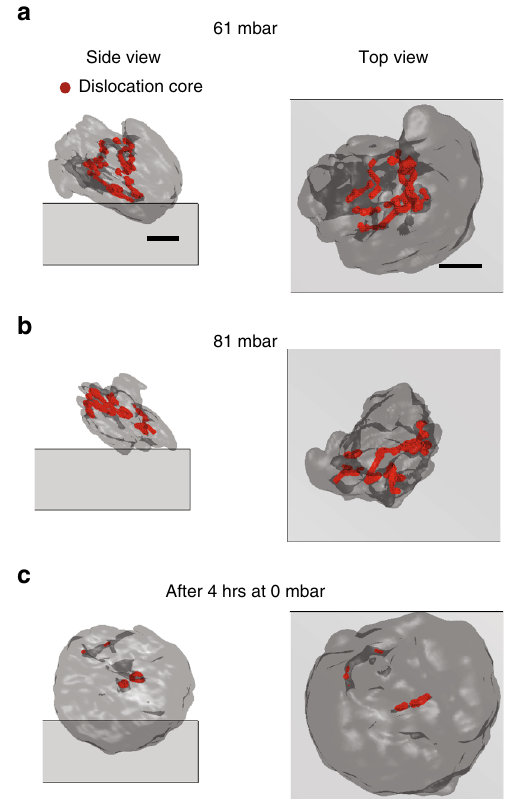
Fig. 2 The 3D dislocation network evolution due to changes in hydrogen partial pressure. The particle shape is shown as a black semi-transparent isosurface, the substrate is shown as a grey plane, and the dislocation line is shown in red. Only the states with a dislocation are shown. The scale bars represent 100 nm. a The dislocation network at 61 mbar. b The dislocation network at 81 mbar. c The dislocation network after 4 h at 0